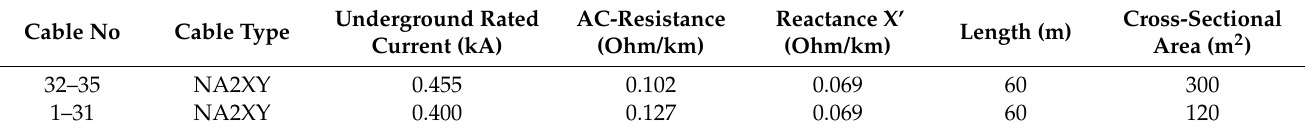
Table 3. Cable characteristics of network 2.